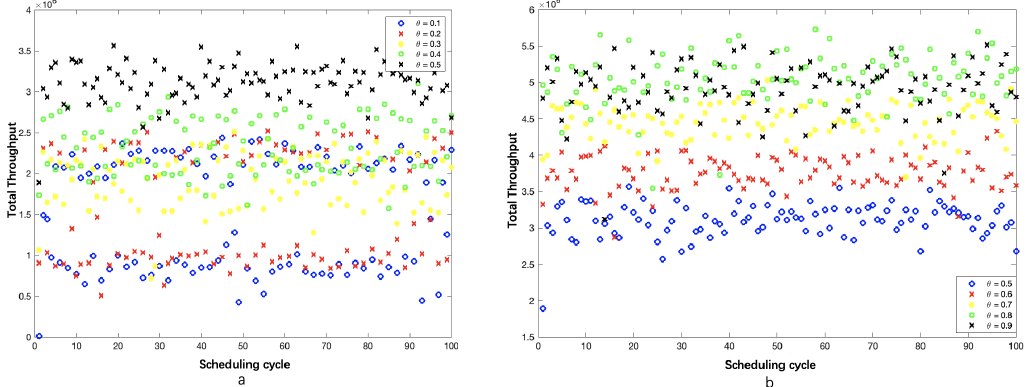
Figure 5. ( a ) θ belongs to 0.1 0.5 throughput; ( b ) θ belongs to 0.5 0.9 throughput.